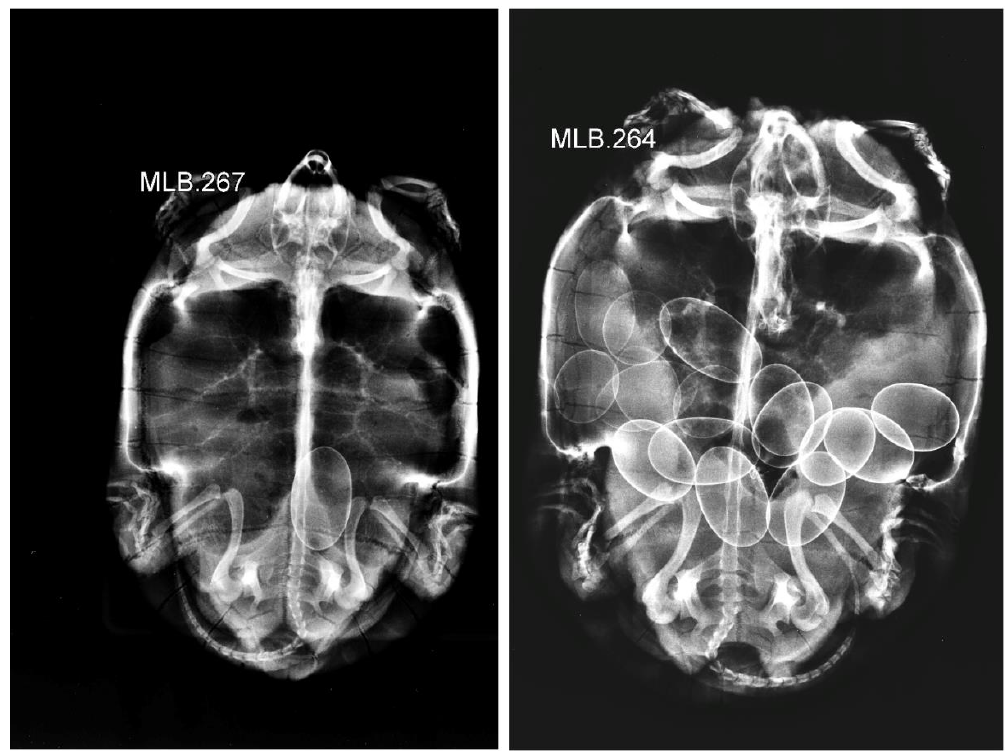
Figure 1. The two extreme clutch sizes (one egg and 16 eggs) detected in the Boukhmira population.